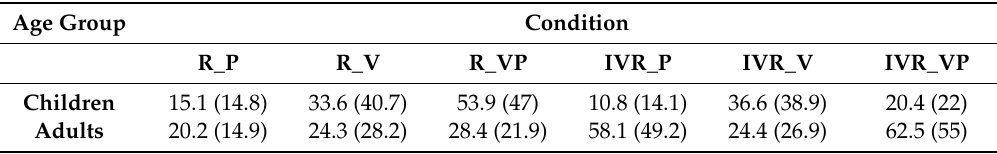
Table 2. Means and standard deviations of self ‐ turn error according to age group and the experimental condition.